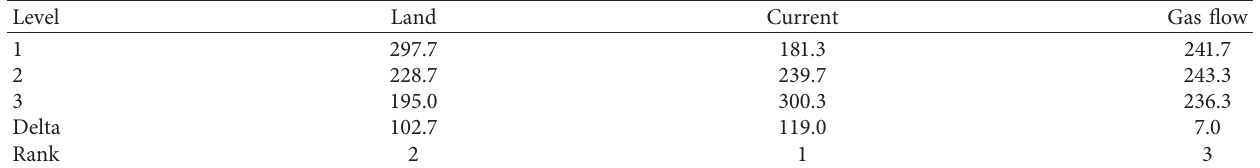
Table 15: Taguchi analysis (residual stresses: smaller is better)—response table for